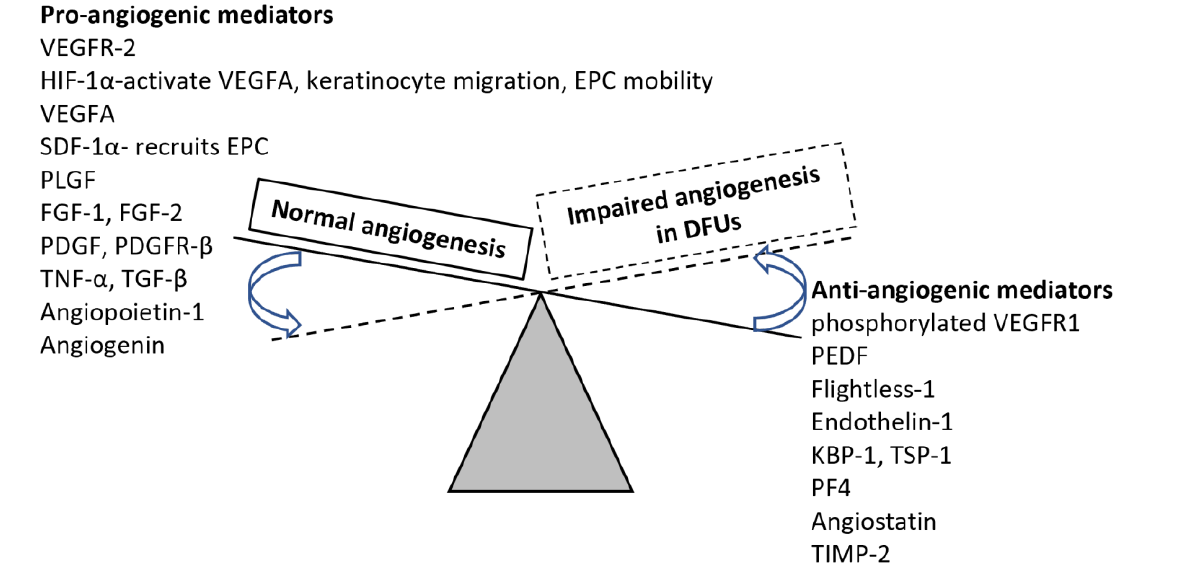
Figure 2. Change in the expression levels of pro-and anti-angiogenic factors in chronic nonhealing diabetes foot ulcers. Normal angiogenesis occurs with increased expression of proangiogenic and decreased expression of antiangiogenic mediators. The expression of proangiogenic factors decreases while antiangiogenic mediators increase in nonhealing diabetic foot ulcers. Vascular endothelial growth factor receptor (VEGFR)-2, hypoxia-inducible factor 1-alpha (HIF- 1α), vascular endothelial growth factor (VEGF) -A, stromal cell-derived factor (SDF)- 1α, placental growth factor (PLGF)— a member of the VEGF family, fibroblast growth factor (FGF), platelet-derived growth factor (PDGF), platelet-derived growth factor receptor (PDGFR)- β , tumor necrosis factor (TNF)- α, transforming growth factor (TGF)- β, pigment epithelium -derived factor (PEDF), Krüppel binding protein (KBP)-1, thrombospondin (TSP)-1, platelet factor (PF)-4, and tissue inhibitors of matrix metalloproteinases (TIMPs). The continuous line shows the expression levels during normal wound healing while the dotted line and arrows represent the shift in expression levels.